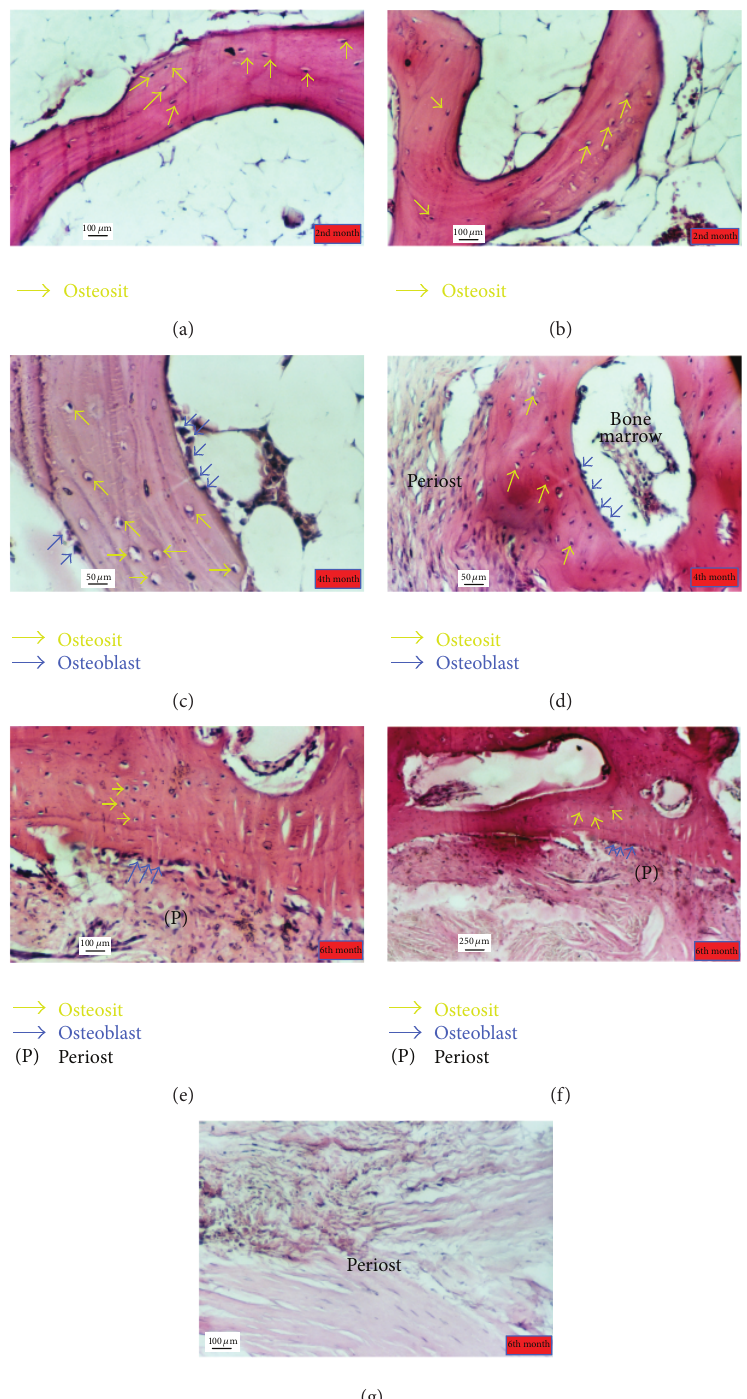
Figure 5: (a, b) Poor osteoblast activity at the end of the 2nd postoperative month. (c, d) At the end of the 4th month osteoblasts are clearly observed. (e, f) More osteoblast activity and healthy periosteum with no immunological reaction at the end of the 6th postoperative month. (g) Normal periosteum and spongiosis bone